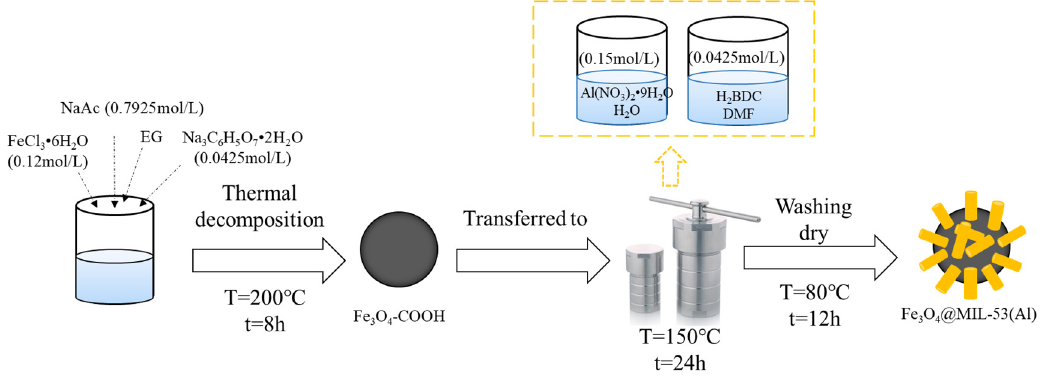
Scheme 1. Illustration of the Preparation Process of Fe 3 O 4 @MIL-53(Al) (T = Temperature; t = time).